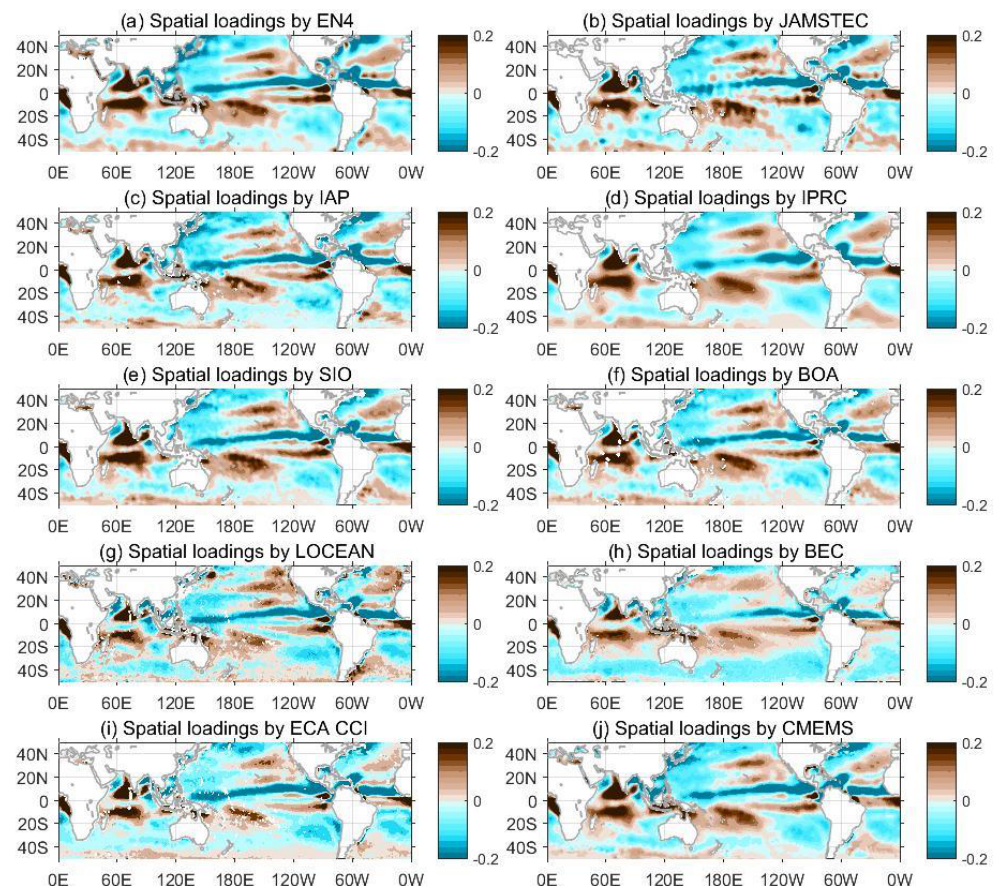
Figure A2. The spatial pattern of the leading mode of the annual SSS variations from ten products. The units are in g/kg.